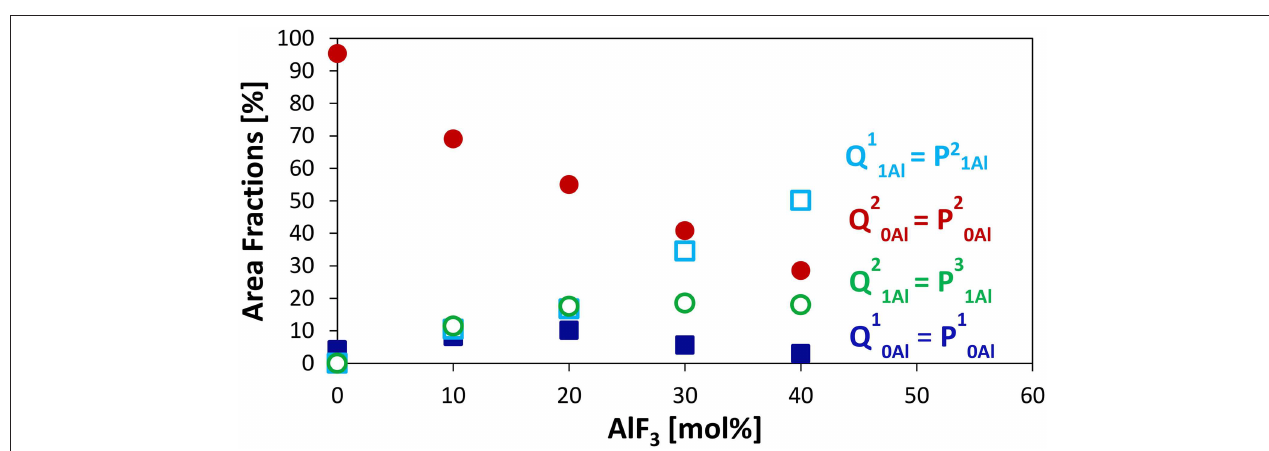
FIGURE 2 | Area Fractions of phosphate Q n m species ( n = number of P neighbors, m = number of Al neighbors) or P q m ( q refers to number of total bridging oxygens, P or Al) from 31 P MAS NMR.